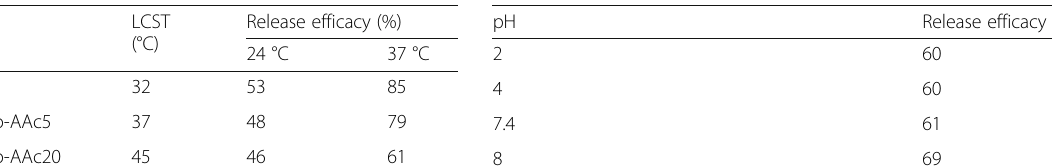
Table 1 LCST and release efficiency of PNIPAM derivatives at